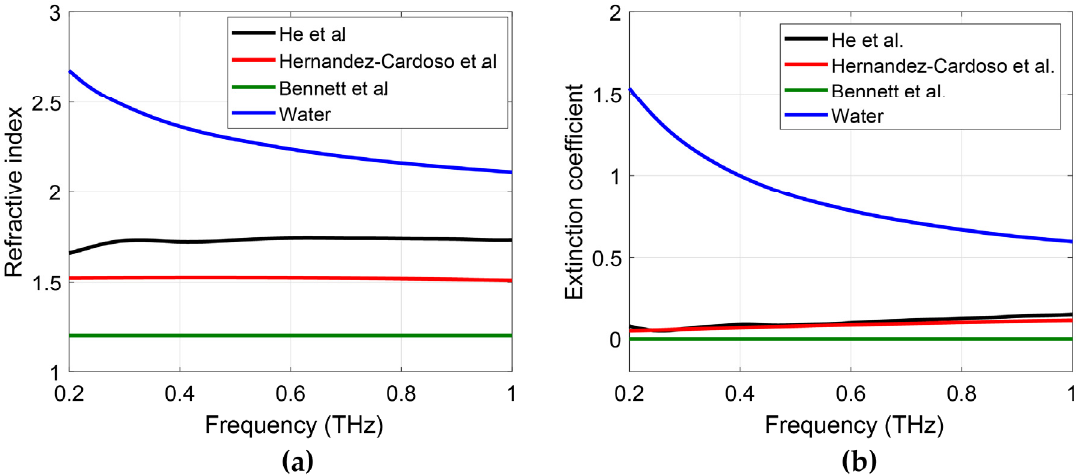
Figure 4. ( a ) Refractive index and ( b ) extinction coefficient of dehydrated skin obtained from work done by He et al. [47], Hernandez-Cardoso et al. [49] and Bennett et al. [51]and compared to that of water. Reprinted with permission from ref. [47]. Copyright 2017 Scientific Reports. Reprinted with permission from ref. [51]. Copyright 2011 IEEE Sensors Journal